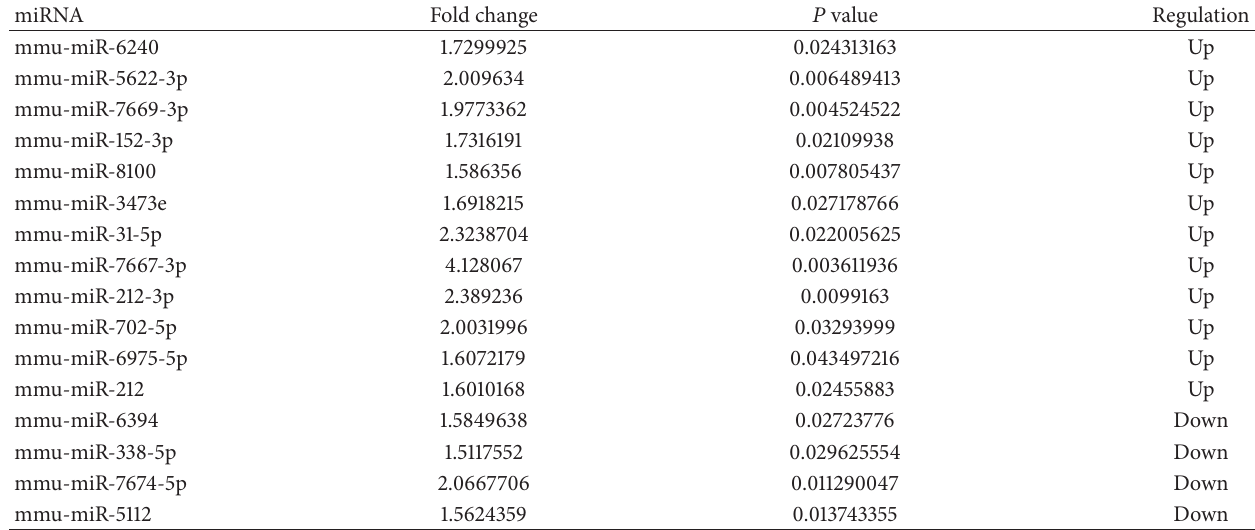
Table 3: Differentially expressed miRNAs in LPS stressed Kupffer cells with or without SNN containing serum treatment. miRNA Fold change 𝑃